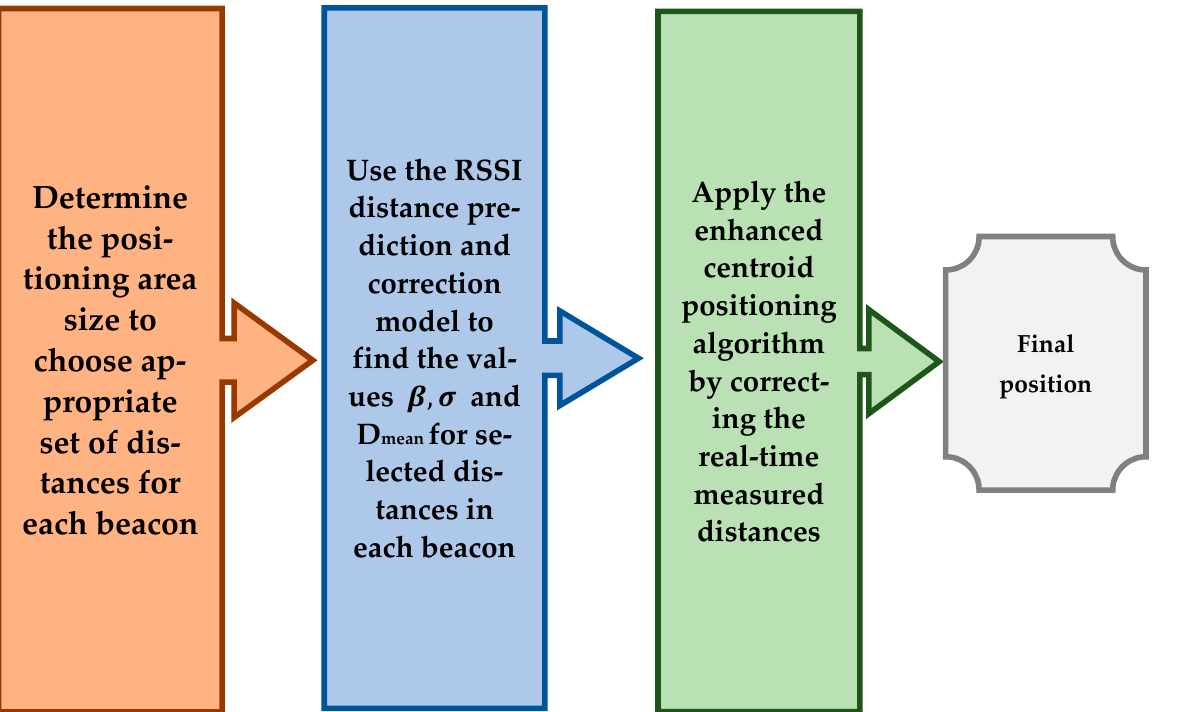
Figure 4. Overall schematic of the proposed positioning technique .